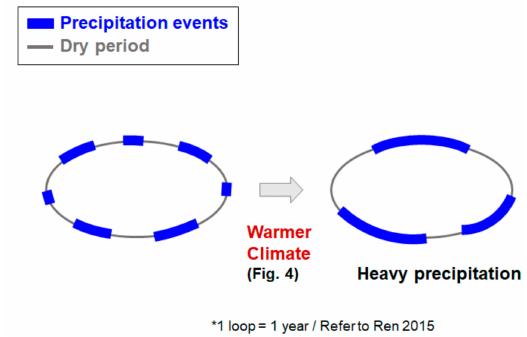
Figure 5. Illustration of extreme precipitation pattern in a warmer climate, reproduced with permission from Ren Diandong, Strom-triggered Landslides in Warmer Climates; published by Springer, 2015 [28]. Blue circles indicate precipitation events (wet days), and gray lines indicate the dry periods in